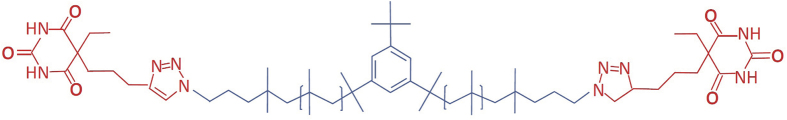
Chemical structure of telechelic Polyisobutylene endfunctionalized with barbituric acid.